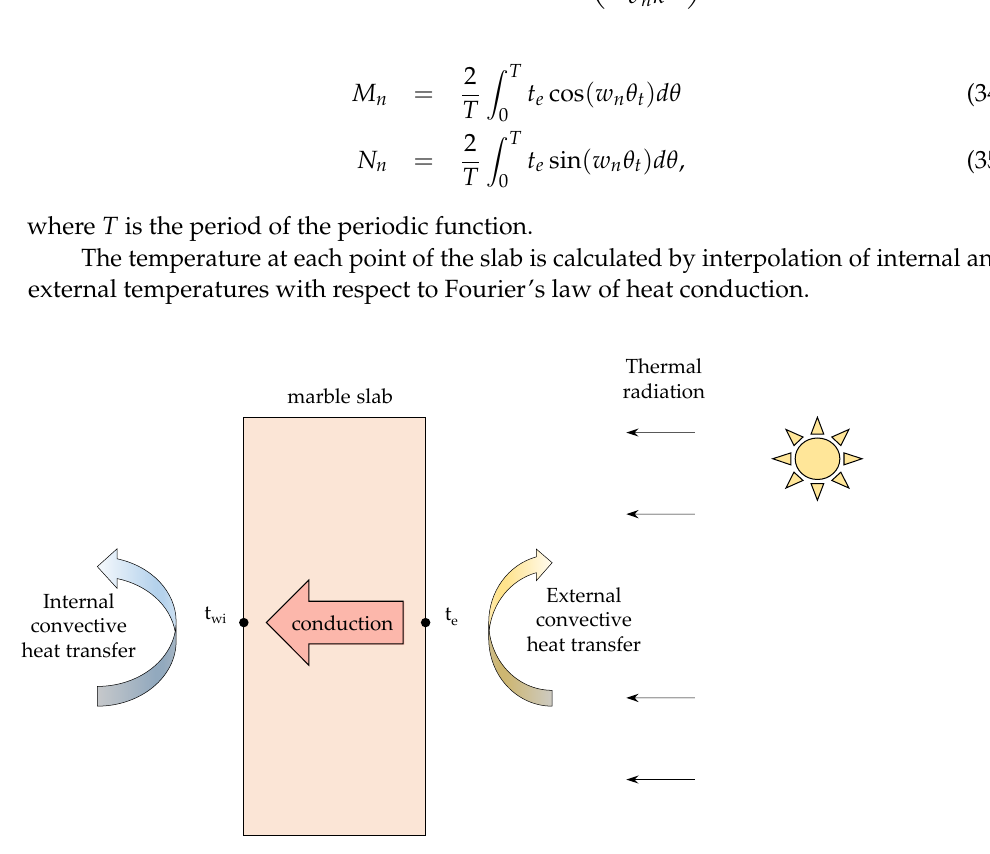
Figure 2. Simplified model of heat flux in a ventilated